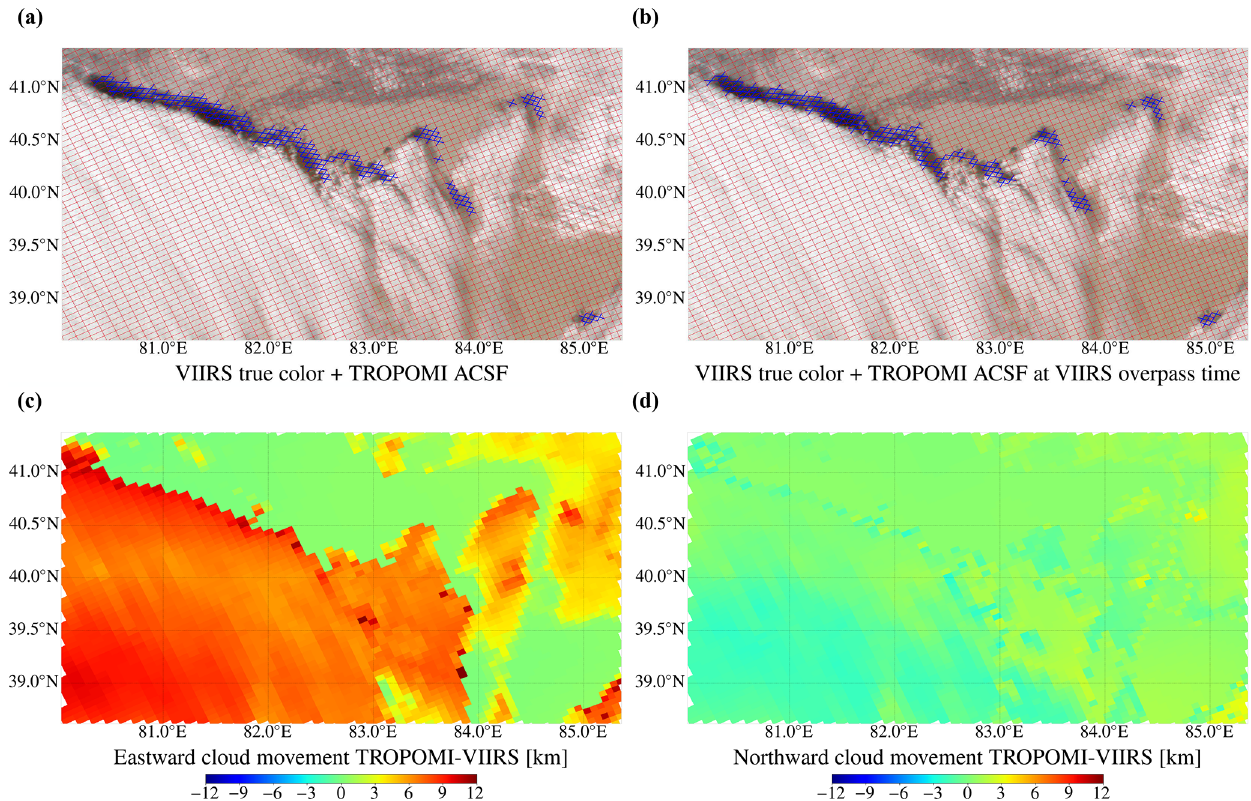
Figure 11. VIIRS-NPP true-colour image of the Taklamakan Desert at Xinjiang, China, 22 December 2019, with the TROPOMI Level 2 UVIS grid plotted on top (in red) and the detected ACSF by DARCLOS (blue crosses), uncorrected (a) and at the VIIRS measurement times (b) . Panels (c, d) show respectively the eastward and northward atmospheric movement at the cloud height during the TROPOMI– VIIRS measurement time difference, computed using ERA5 reanalysis wind